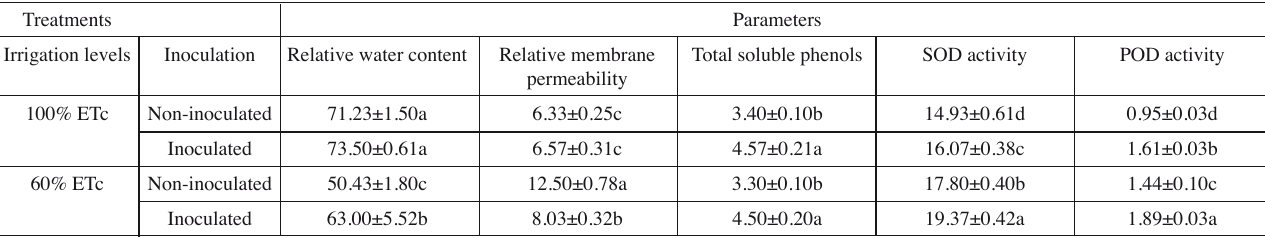
Tab. 5: Effect of Azospirillum lipoferum inoculation on relative water content (RWC %), relative membrane permeability (RMP %), total soluble phenols (mg g −1 DW) and the activities of superoxide dismutase (Units g −1 FW leaf min −1 ) and peroxidase (Units g −1 FW leaf min −1 ) of wheat ( Triticum aestivum L., cv. Giza-168) plants grown under non-stressed and drought-stressed